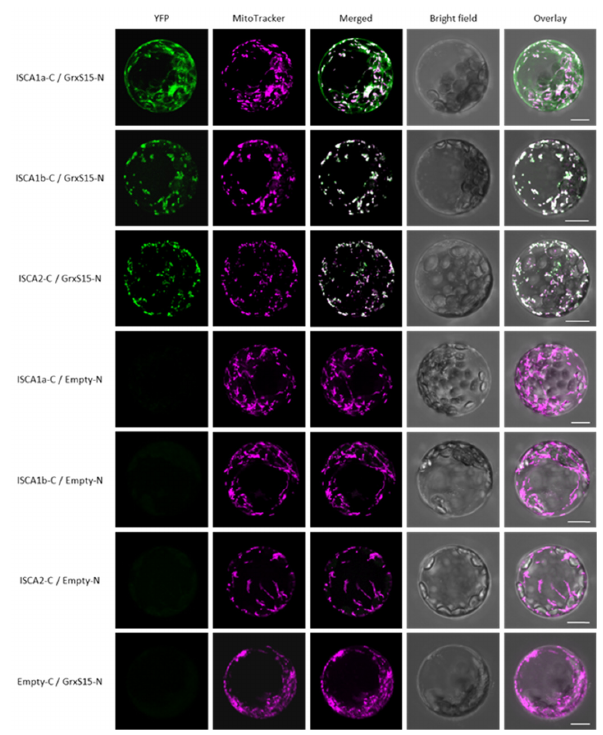
Figure 2. BiFC assays between arabidopsis GRXS15 and ISCA proteins in arabidopsis leaf protoplasts. Arabidopsis protoplasts obtained from four week-old plantlets were transfected with combinations of two vectors expressing GRXS15 fused to the N-terminal region of YFP (GRXS15-N in panels) and ISCAs cloned upstream of the C-terminal region of YFP (ISCA-C in panels). The YFP fluorescence was recorded 24 h post-transfection by confocal microscopy. All confocal images shown here were captured using a maximum Z-stack intensity projection. Images showing confocal plans without Z-stack intensity projection are shown in Figure S3. Negative controls verifying that none of the proteins expressed alone can restore YFP fluorescence are shown. BiFC results obtained using opposite protein fusion conformations (GRXS15-C coexpressed with ISCA-N) showed less clear-cut results as a strong fluorescence in the cytosol suggested the formation of aggregates was obtained for some combinations. Bars = 10 µ